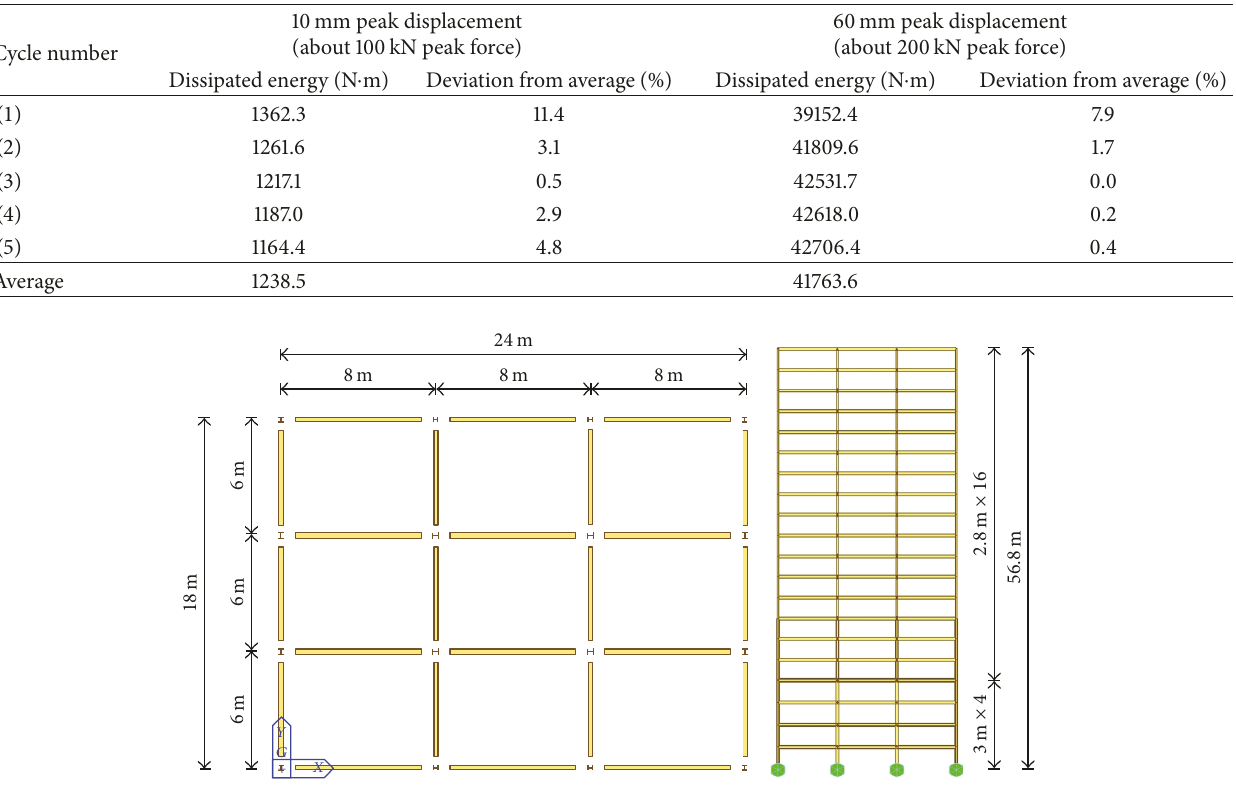
Figure 12: Plan and elevation of a 20-story steel